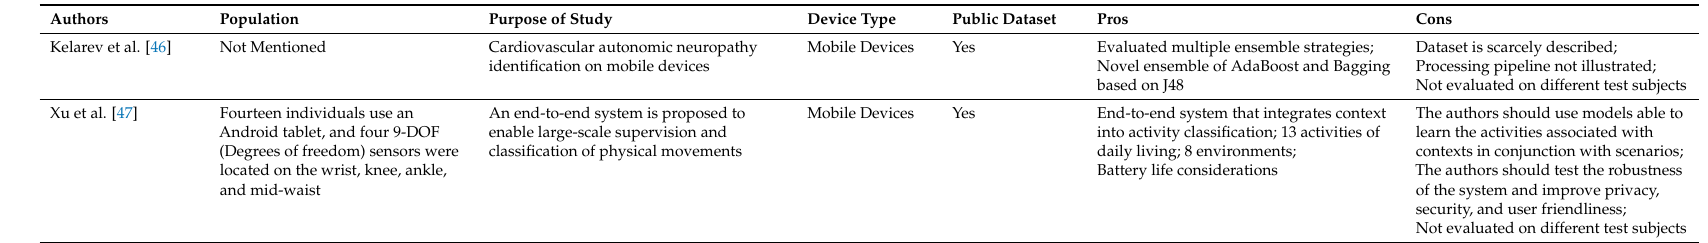
Table 2. Critical analysis of reviewed